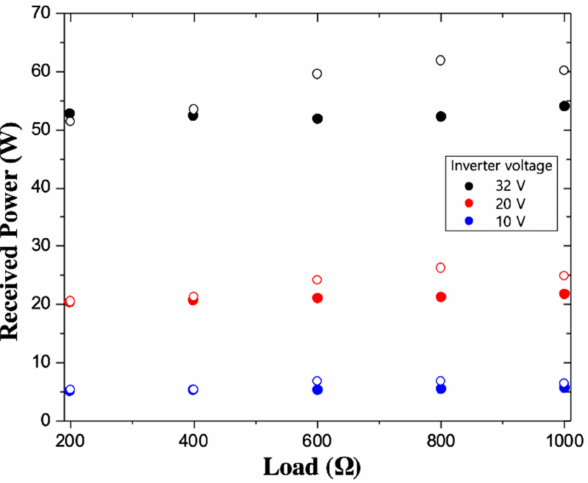
Figure 9. The output power at the load respect to load variation with different direct current (DC) voltage at inverter. The solid and empty dot denotes measurement using manually optimized capacitor and 4-channel relay capacitor network, respectively. Note that the amount of power delivered to the load does not depend on the load resistance.